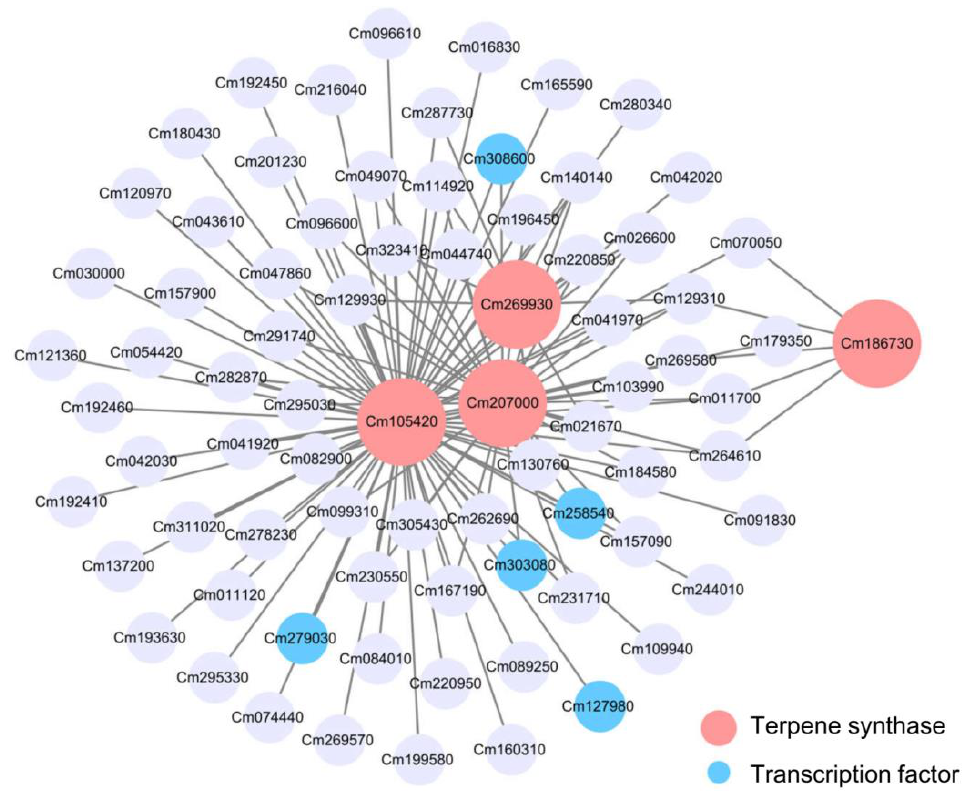
Figure 7. Gene co-expression subnetwork of Module Red. Network was reconstructed by edge weight cutoff = 0.35 and visualize by cytoscape. Gene IDs and annotations in Module Red subnetwork were listed in Table S4.